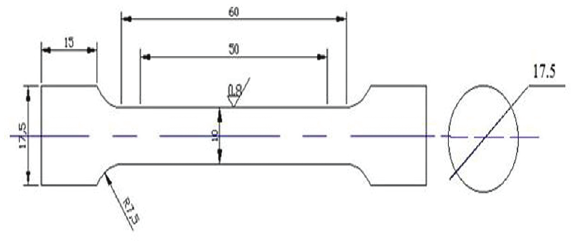
Figure 3: XRD traces of Ti-7Cu alloys with different deformation